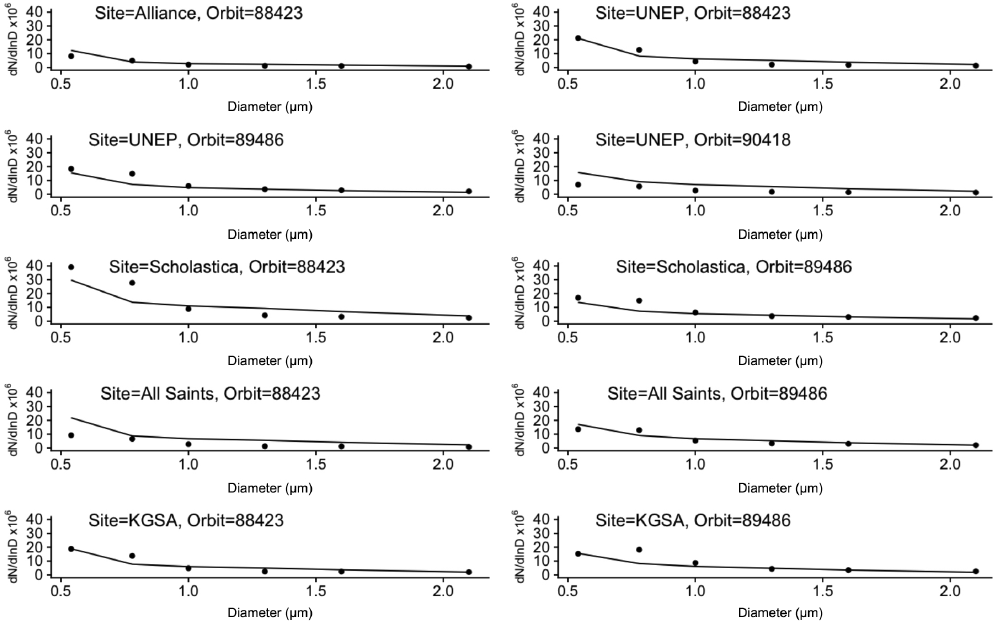
Figure 2. Ground-based size distributions (numberm − 3 ) obtained from the low-cost air quality monitors, represented by points at the bin- center diameters (µm) for each of the OPC bins 2–7, and the corresponding size distribution derived from the 10 favorable MISR retrievals (represented by lines). The orbit number of the satellite observation is provided along with which ground-based monitor location with which the satellite pixel